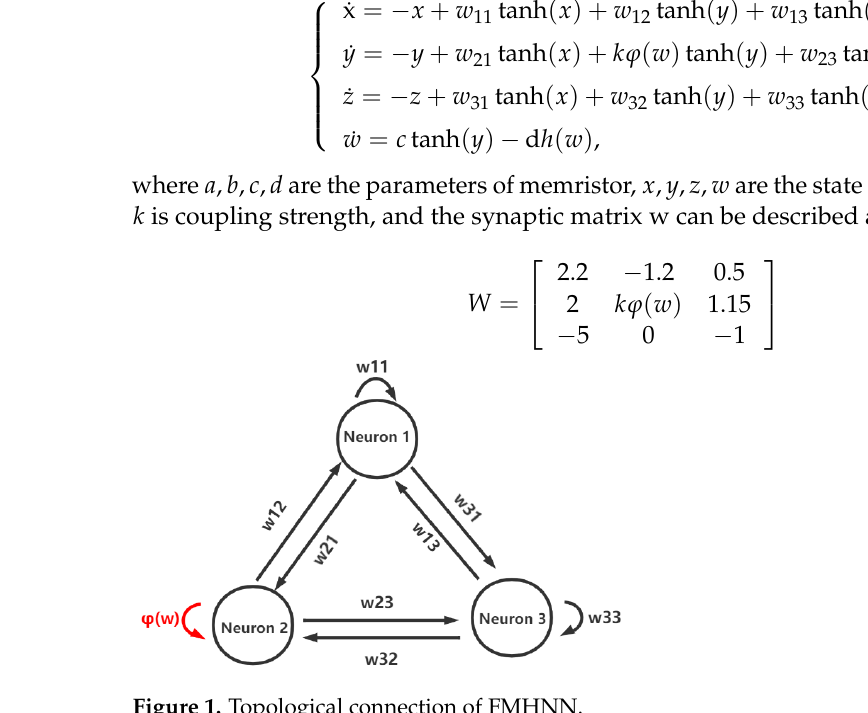
Figure 1. Topological connection of